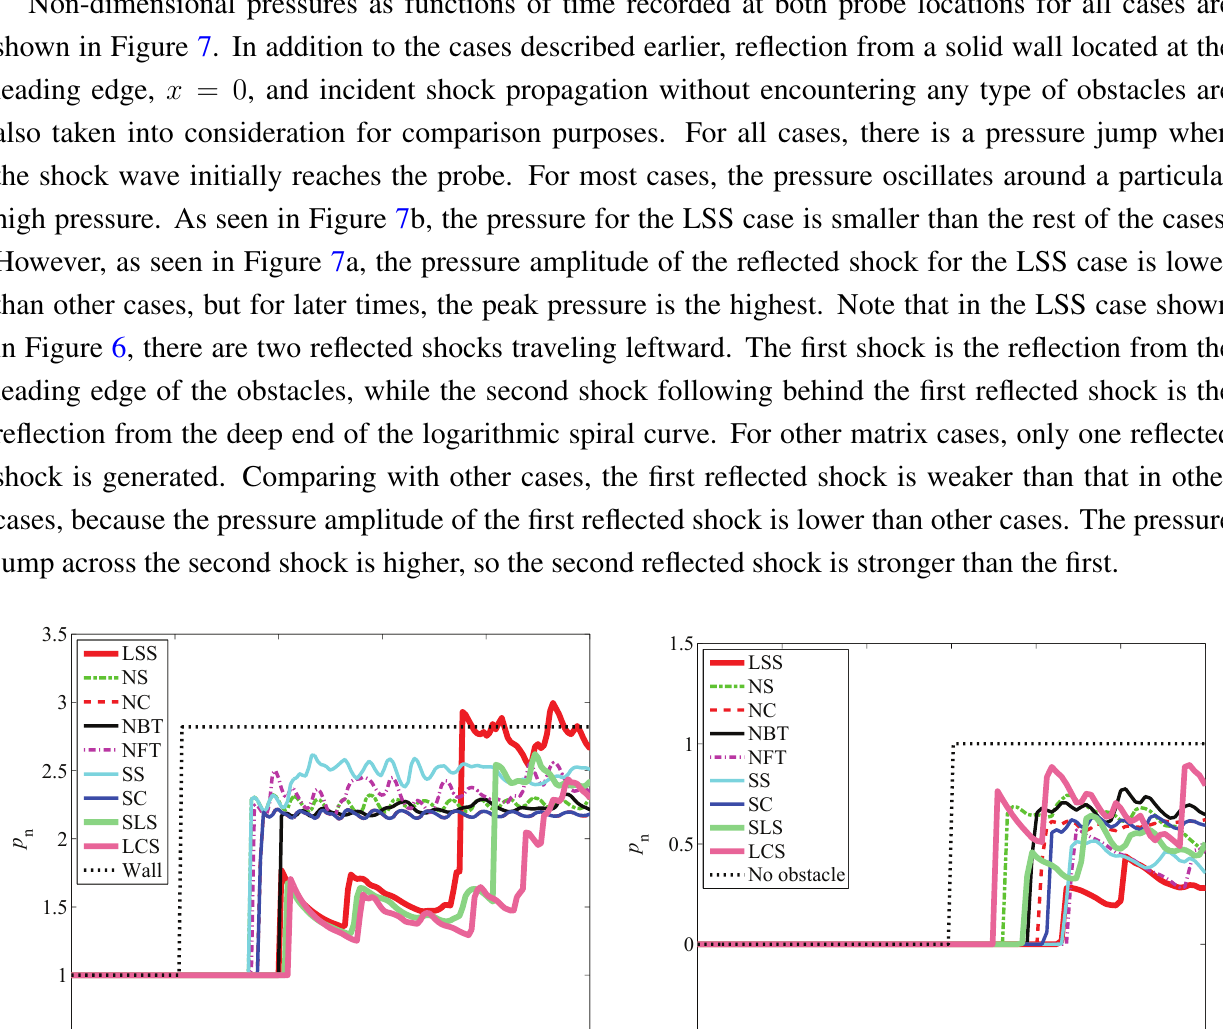
, at ( a ) upstream probe ( x, y ) = ( − 50 , 0) and n